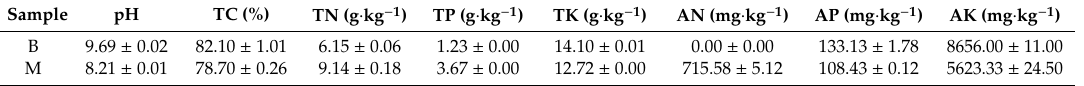
Table 1. Two kinds of biochar chemical